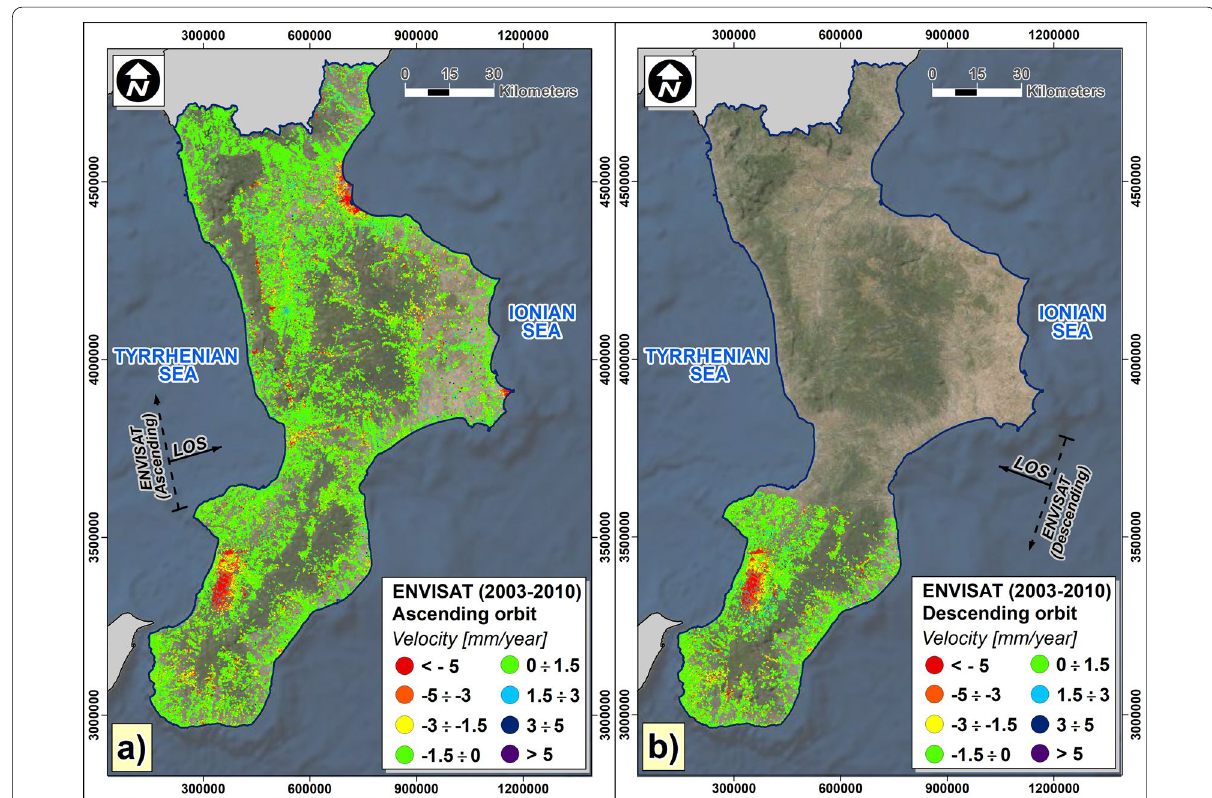
Fig. 6 Distribution of DInSAR velocities recorded along the sensor-target Line of Sight (LOS) on a ascending and b descending orbits deriving